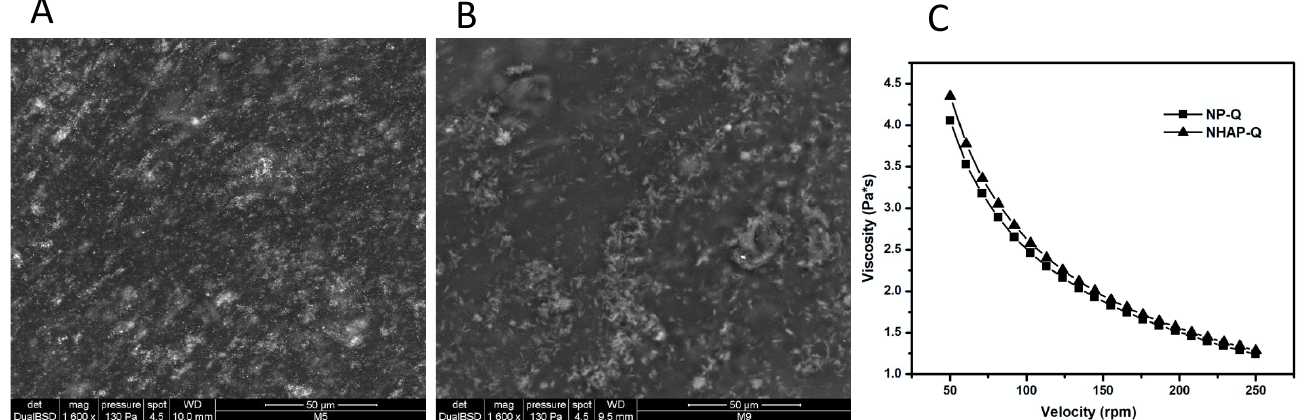
Figure 3. Rheological characterization of the colloidal chitosan dispersions. ESEM was used to characterize the ( A ) AgNP-Q (scale bar: 50 µ m) and ( B ) colloidal NHAP-Q chitosan dispersions (scale bar: 50 μ m). ( C ) The viscosity of both colloidal chitosan dispersions was measured.